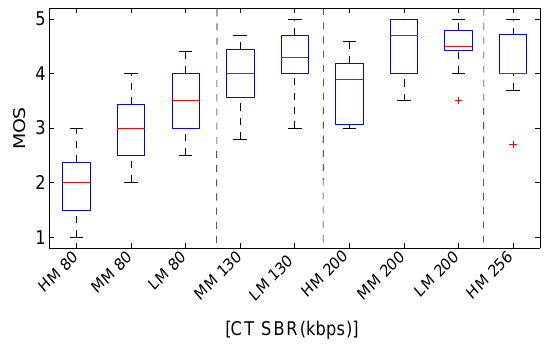
Table 2. Encoding settings for subjective tests.